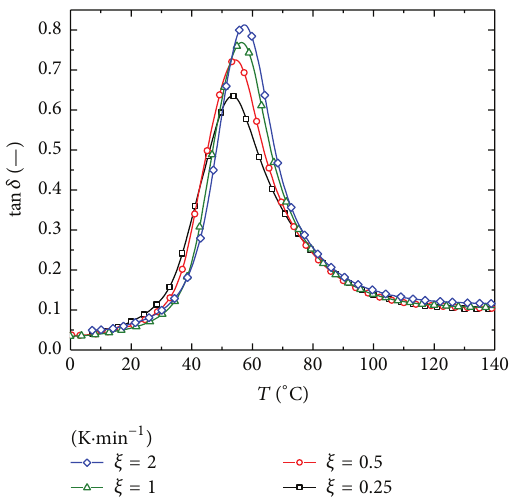
Figure 6: Temperature sweep tests with different heating rates: variation of loss factor with temperature.